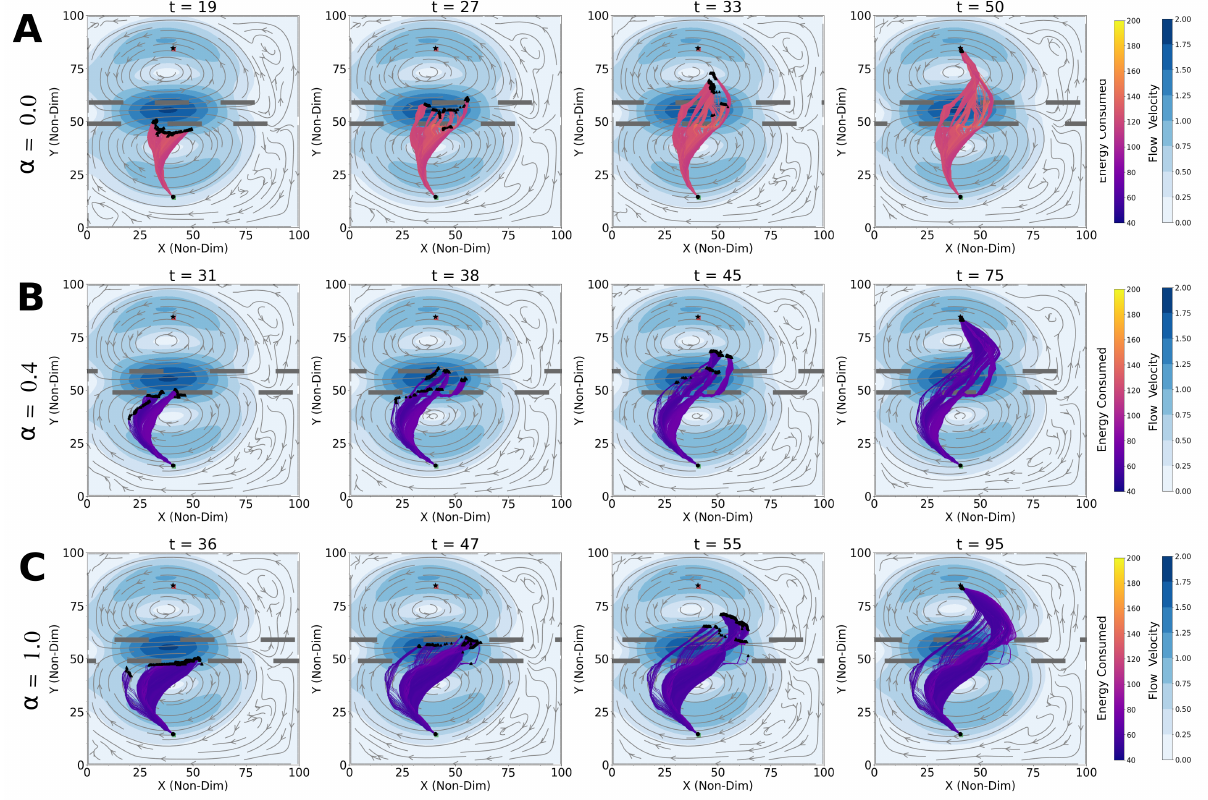
Figure 7. Time evolution of trajectory distribution obtained by following the optimal policy for different α values for the “shipping channel crossing” mission: ( A ) α = 0, equivalent to time optimal planning; ( B ) α = 0.4, intermediate behavior between α = 0 and α = 1; ( C ) α = 1, equivalent to energy optimal planning.